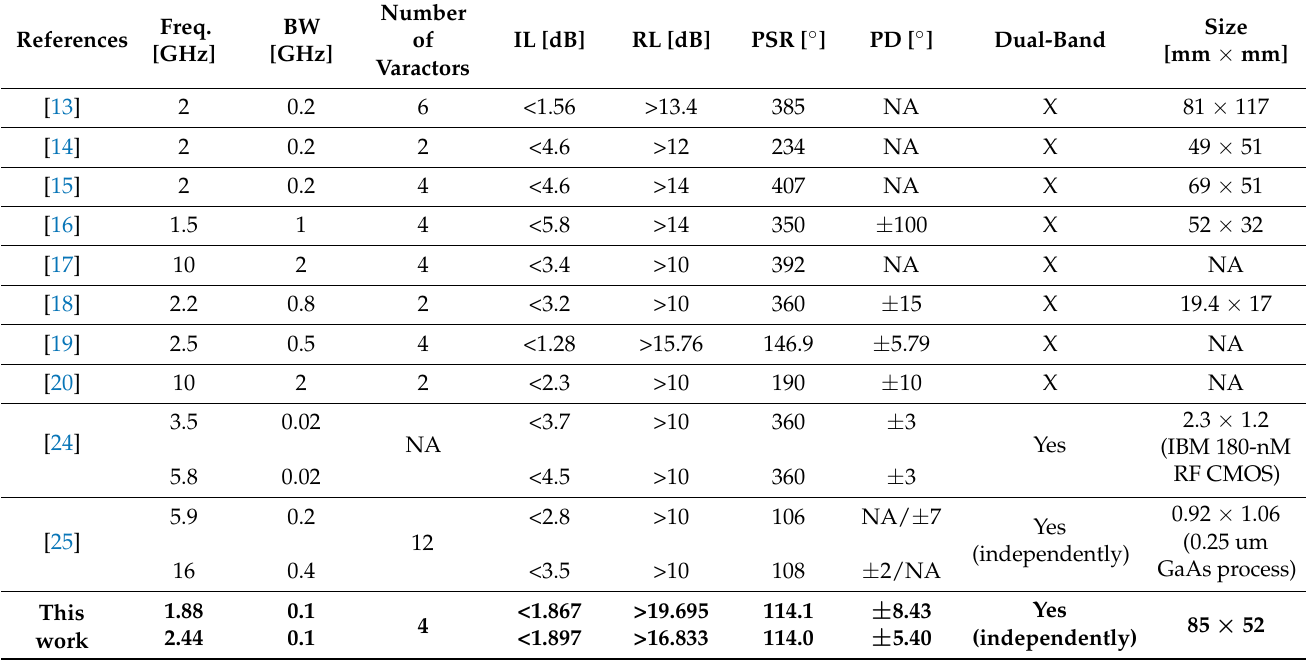
Figure 11. Simulated and measured results of a dual-band PS achieved by simultaneously varying the bias voltages of the low − and high − band: ( a ) PSR; ( b ) ILs and input/output RLs.